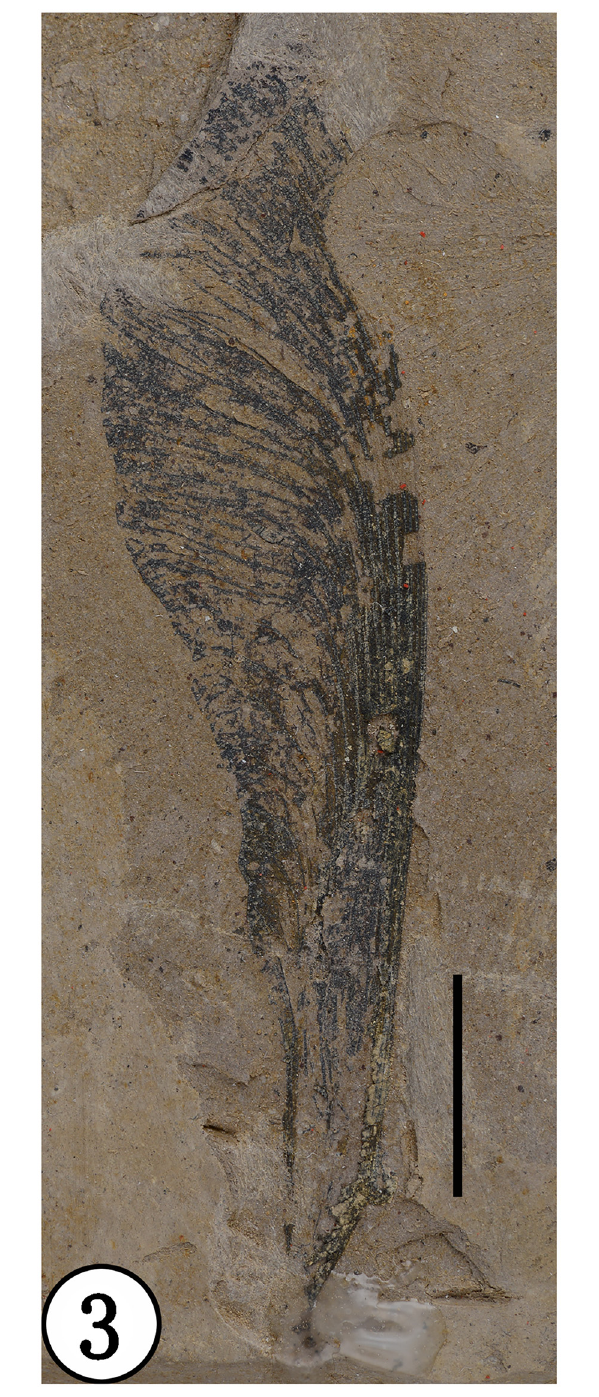
Fig 3. Holotype (NHMG030165), preserved at the Guangxi Museum of Natural History, China. Scale bar = 1 cm.